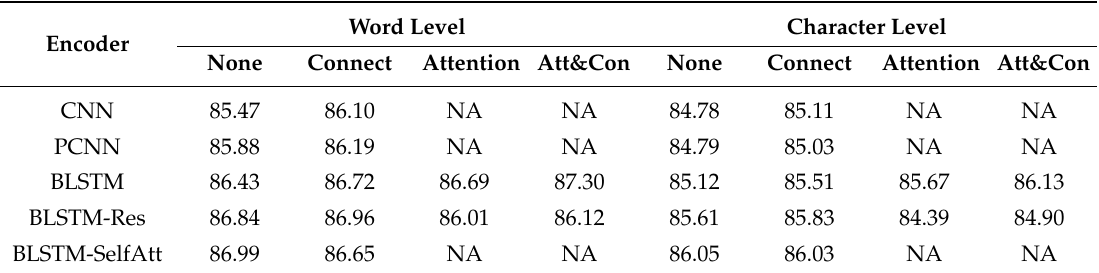
Table 4. Comparison of F1 score in different